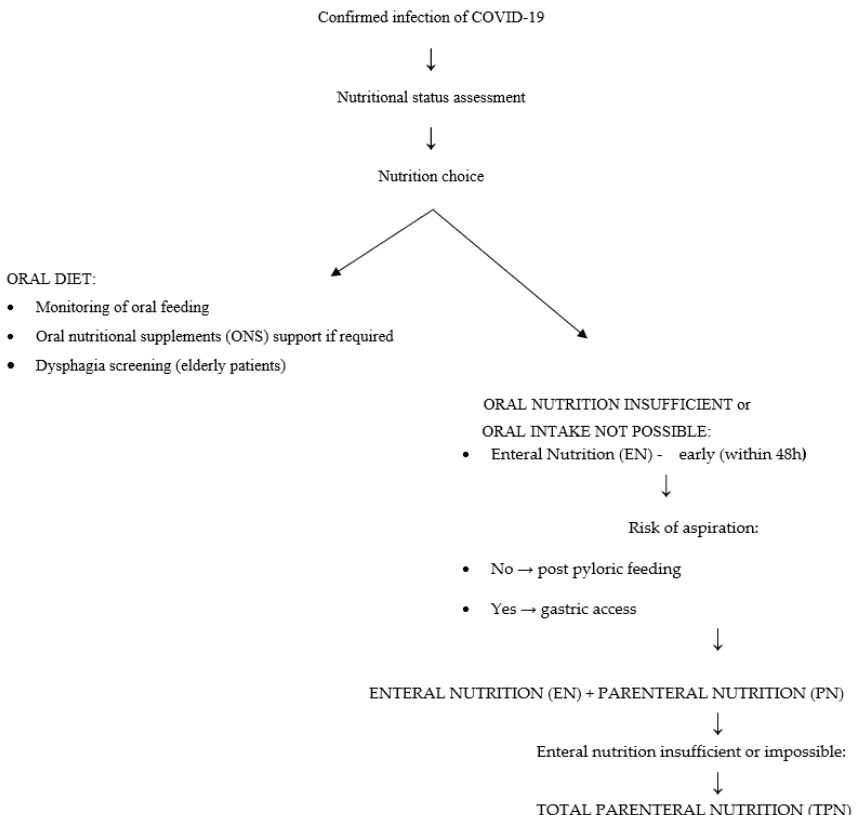
Figure 2. A diagram of dietary management in COVID-19 in hospital conditions. Modifications were based on the “ESPEN guideline on clinical nutrition in the intensive care unit [45]”.